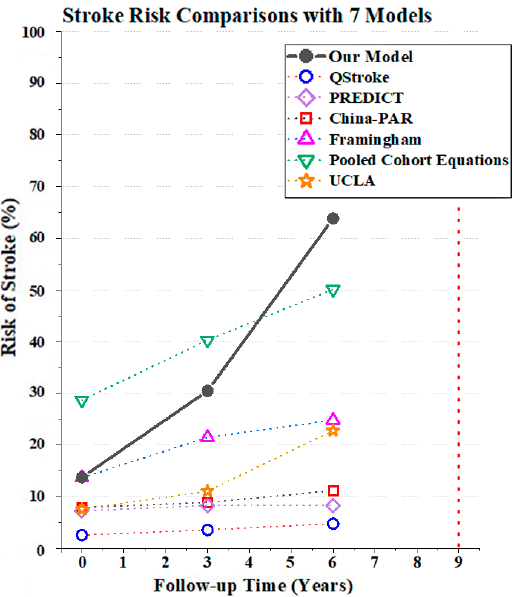
Figure 6. Stroke risk comparisons with seven models based on Subject 1, who was identified as having had a stroke between years 6 and 9. The solid black line and black dots are based on the model used in this paper. Other dotted lines with hollow shapes, in different colors denote the prediction results produced by other stroke risk calculators. Details can be found in the legend and in Table 4. Table 4. Stroke risk comparison information, applying seven models to the case of Subject 1. The stroke risk levels are also shown when available.